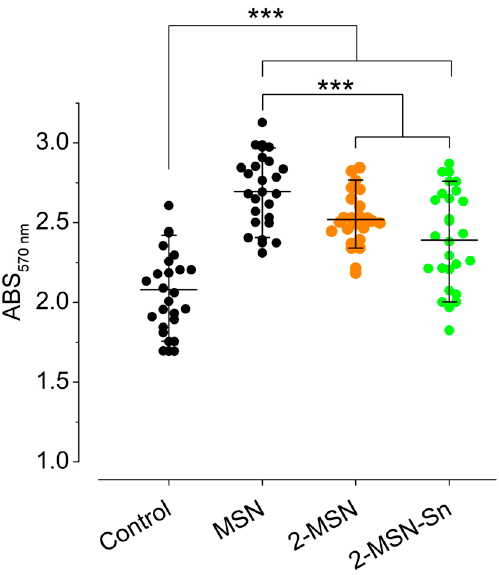
Figure 5. S. aureus biofilm-nanoparticle interaction of MSN , 2-MSN and 2-MSN-Sn materials at 250 μ g/mL. *** p -value < 0.001 from Mann–Whitney test. The bars indicate median and interquartile range.